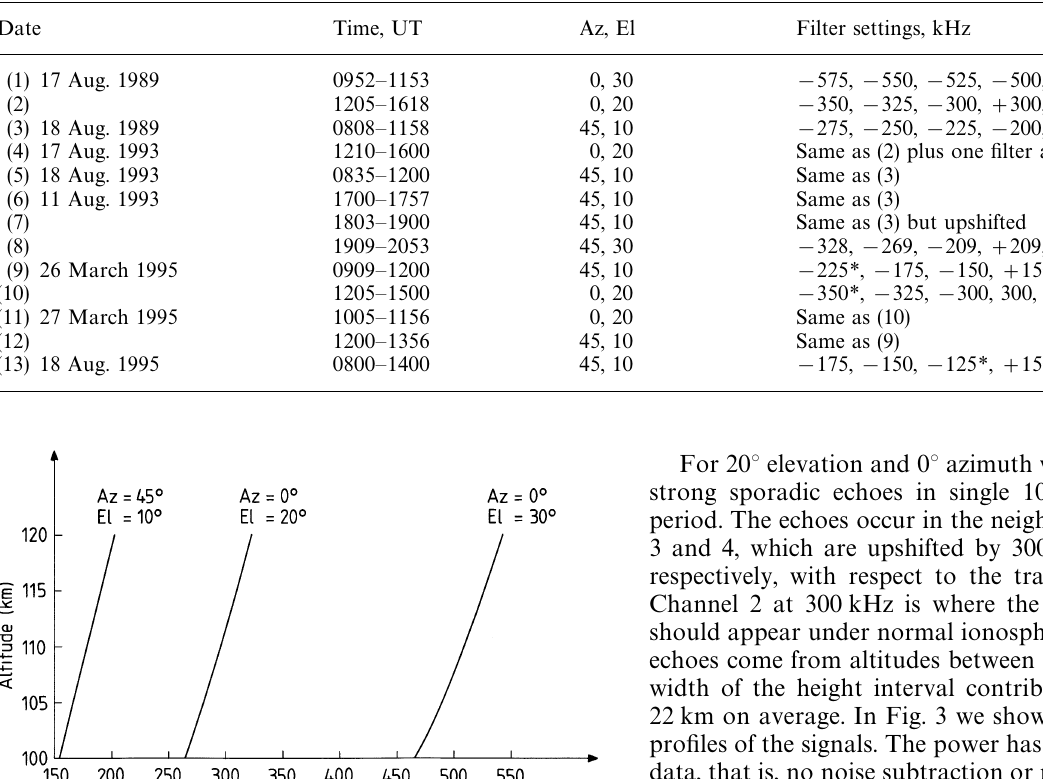
the other filters have a $ 12.5-kHz bandpass. On 26 March the system was not working properly all the time and actually only 3.5 h of data were recorded